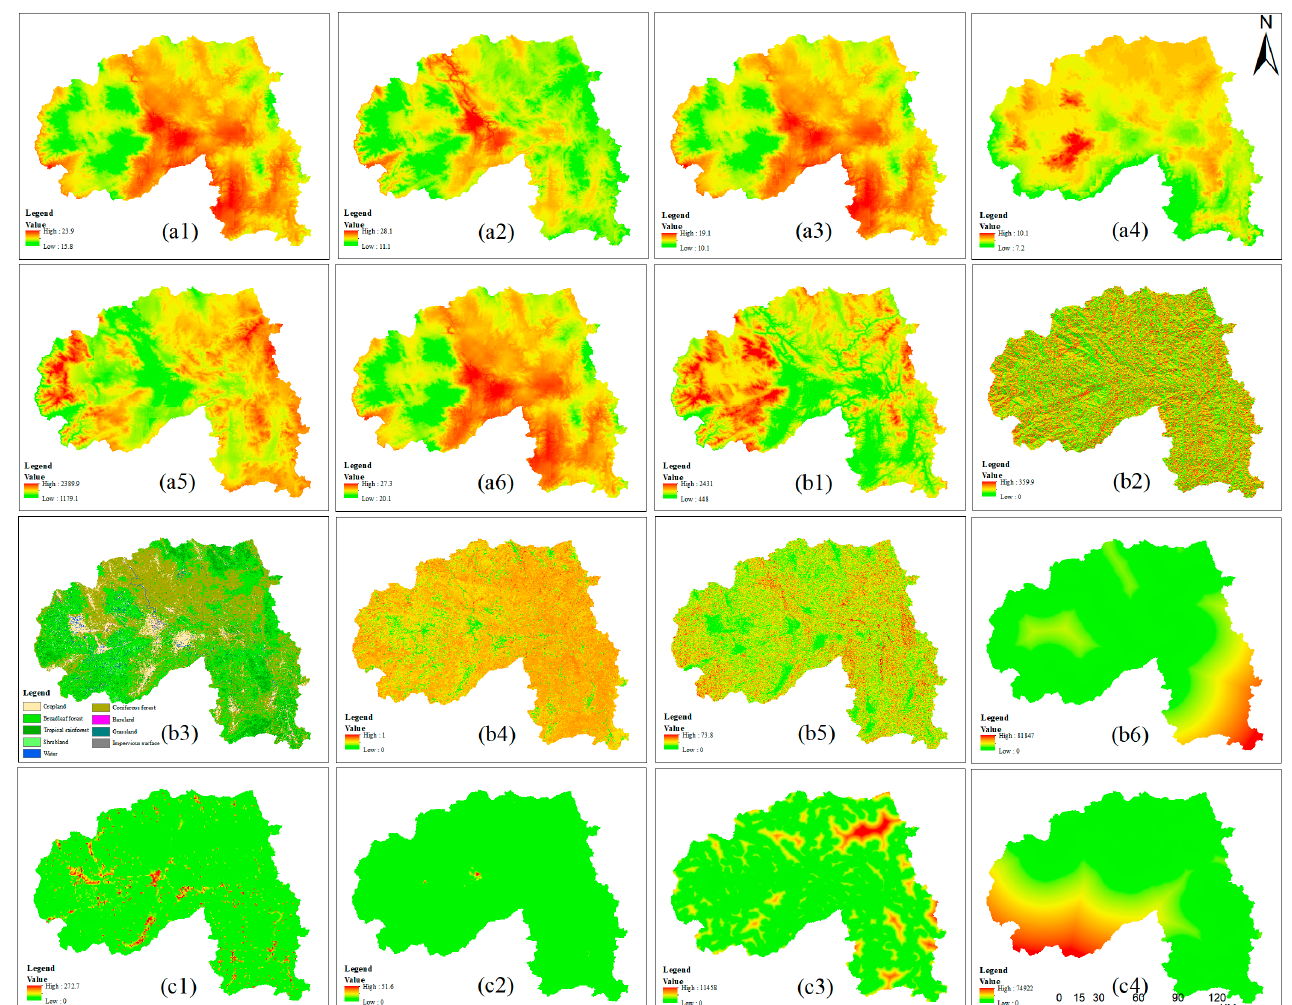
Figure 3. Sixteen environmental factors under current climate conditions: ( a1 – a6 ) climate factors: MAT, AHM, MCMT, TD, MAP, and MWMT; ( b1 – b6 ) natural factors: Alt, Aspect, VCT, NDVI, Slope, and Dis_river; ( c1 – c4 ) anthropogenic factors: PD, NL, Dis_road, and Dis_res. The definitions, units, and abbreviations of the environment variables are listed in Table